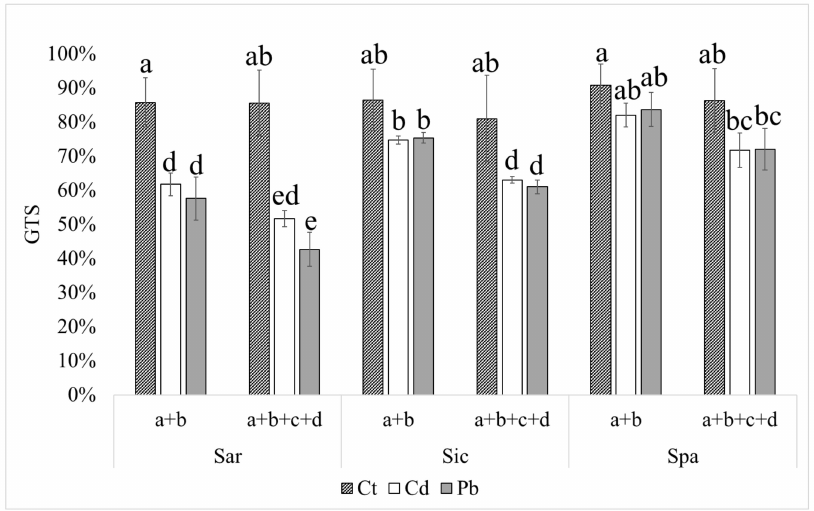
Figure 1. Average genome template stability (GTS, expressed as percentage) and standard deviation ( n = 3) in control (Ct), cadmium treated (Cd), and lead treated (Pb) cardoon cultivars Sardo (Sar), Siciliano (Sic), and Spagnolo (Spa). Different letters indicate significant differences according to Tukey’s test, p <